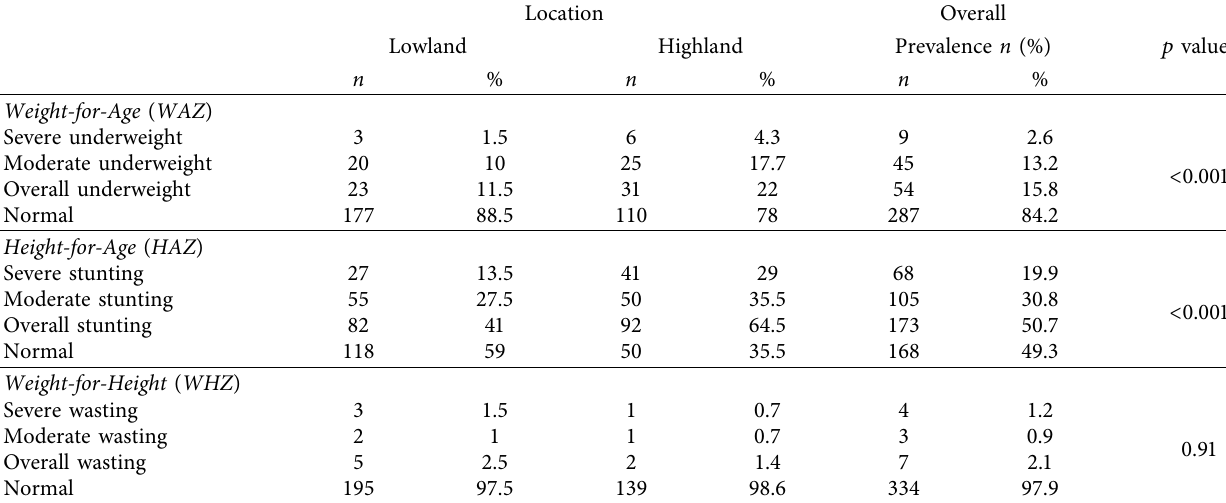
Table 3: Child nutritional status in lowland and highland